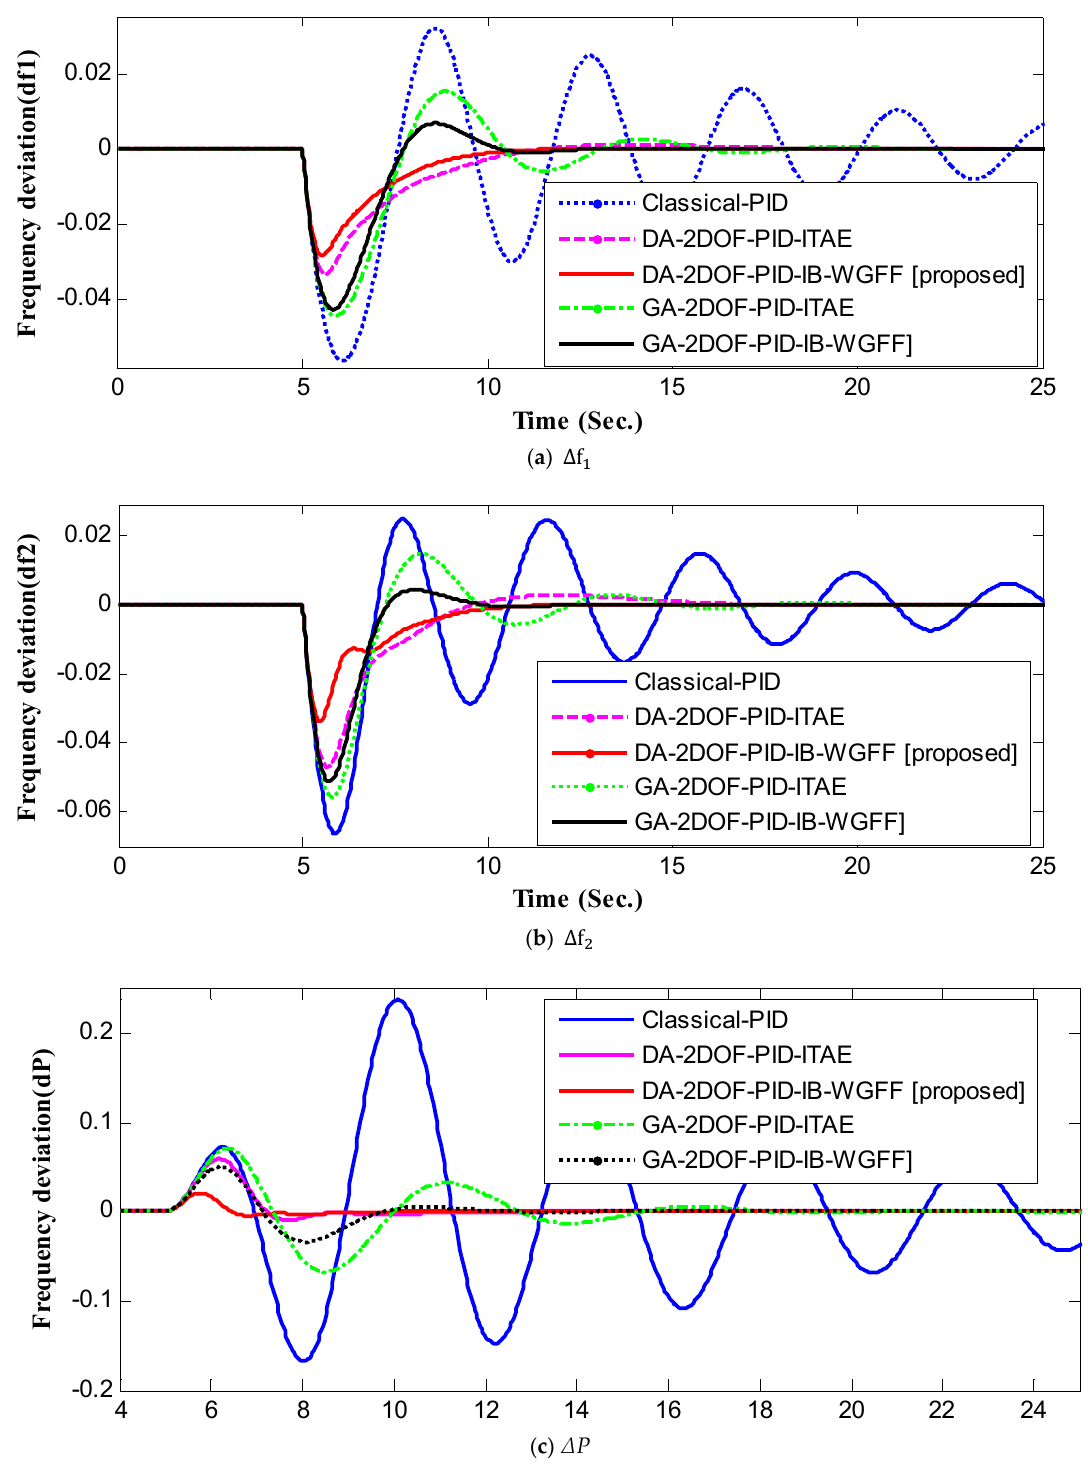
Figure 33. Dynamic Response due to the increase in T12 by a value of 50%.